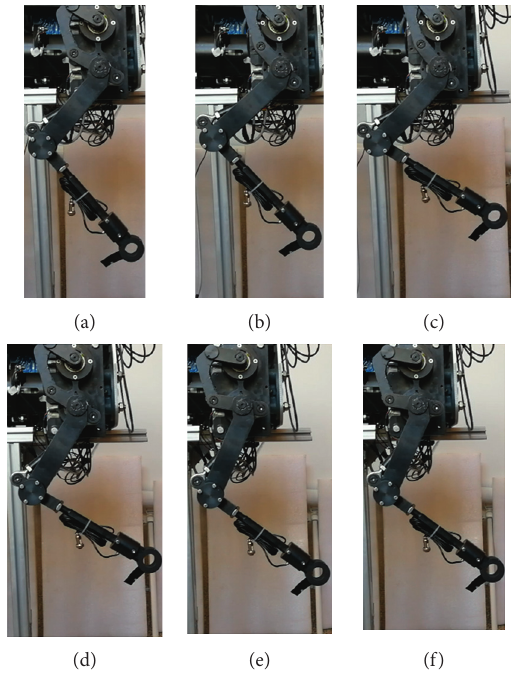
Figure 22: Process of the leg movement.